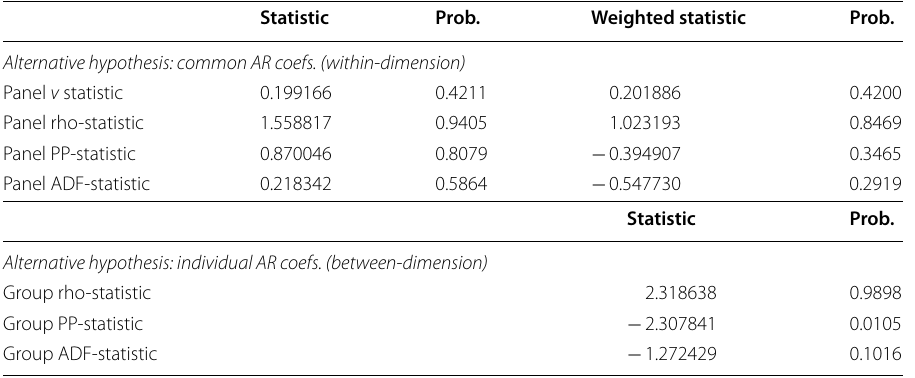
Table 3 Pedroni cointegration residual test Statistic Prob. Weighted statistic